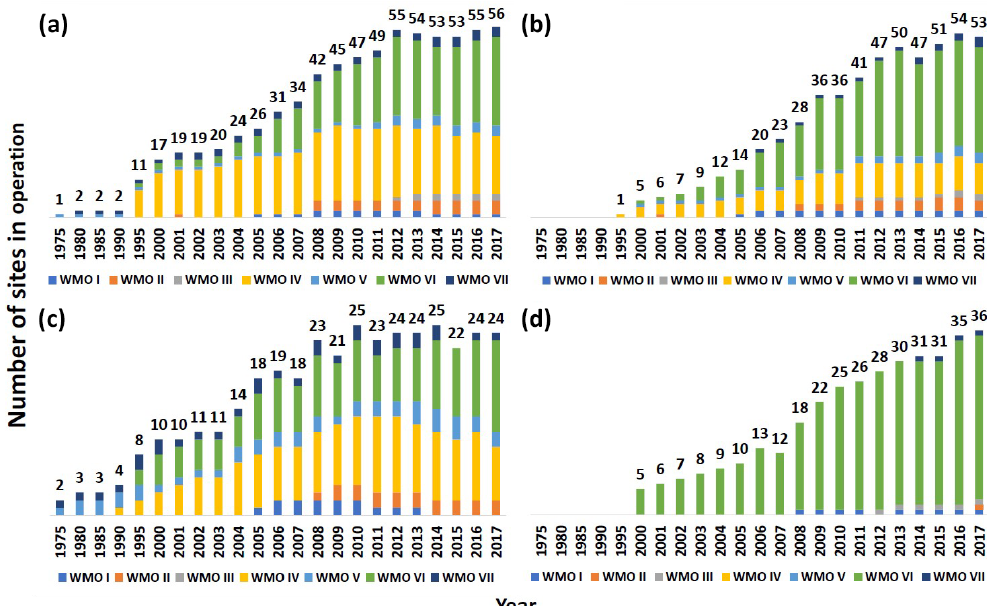
Figure 2. The evolution of data provision in SARGAN for optical (a, b) , and physical parameters split between sites providing particle number concentration (c) and sites providing particle number size distribution (d) over the period 1975–2017 for the WMO regions. WMO I: Africa, WMO II: Asia, WMO III: South America, WMO IV: North America, central America, and the Caribbean, WMO V: south-western Pacific, WMO VI: Europe, WMO VII: polar.